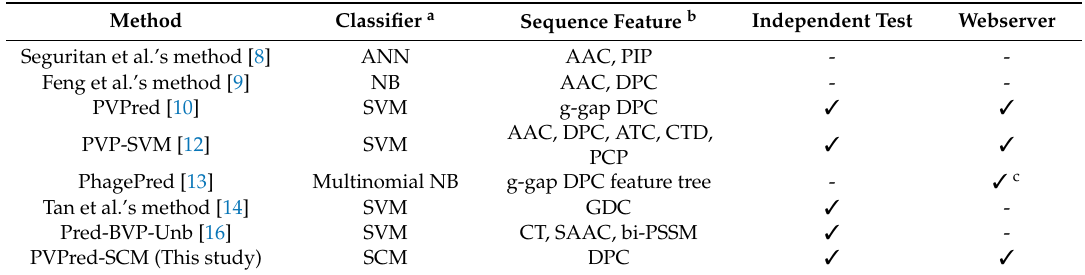
Table 1. Summary of some existing methods for predicting phage virion